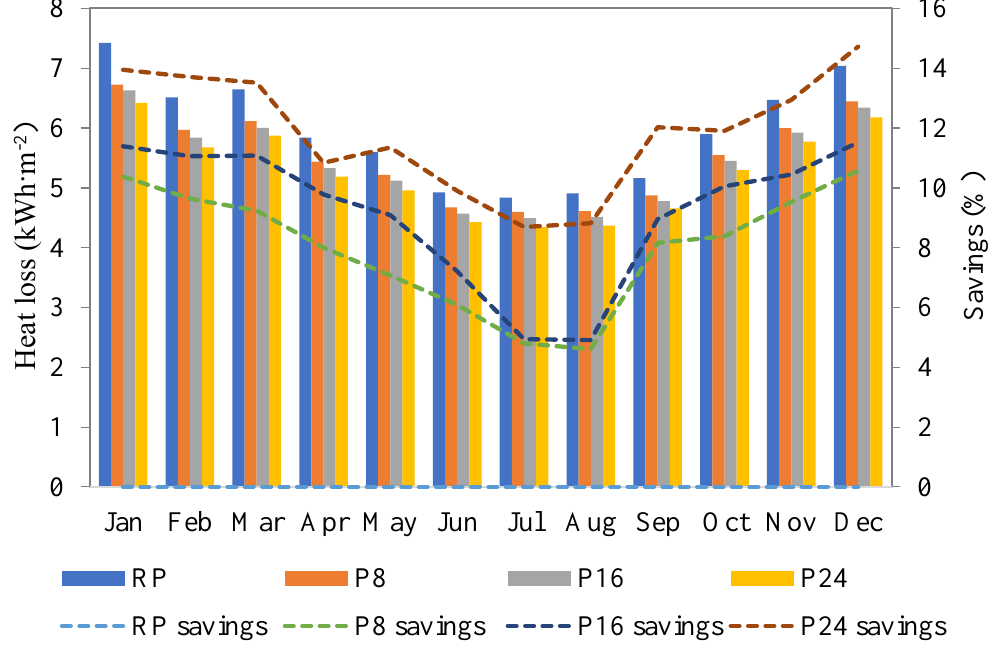
Figure 5. Monthly heat losses and energy savings in Prague.